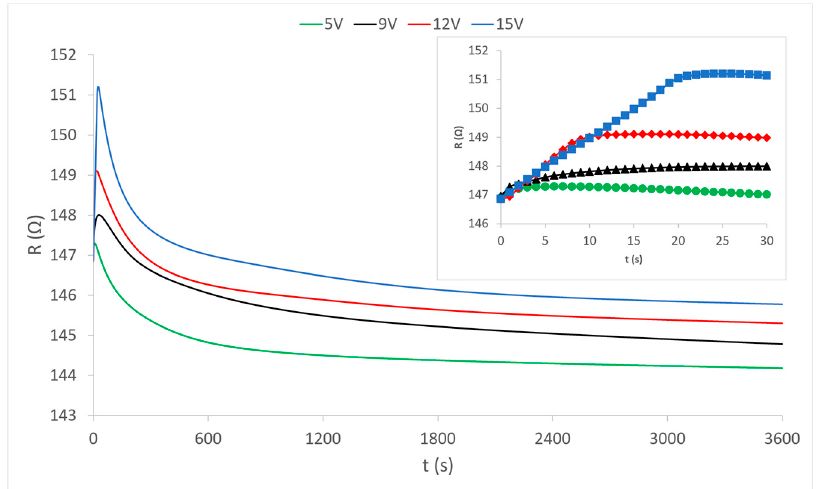
Figure 5. Change in resistance of the electrically conductive yarn of sample 2 under the influence of heat at given voltages.